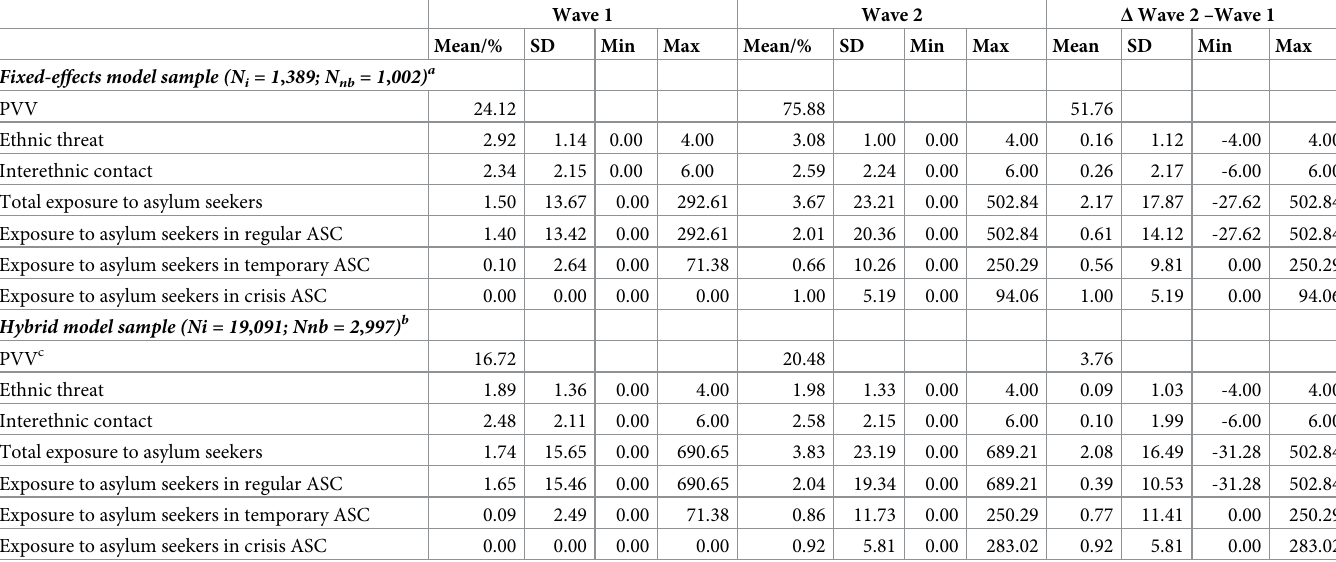
Table 1. Descriptive